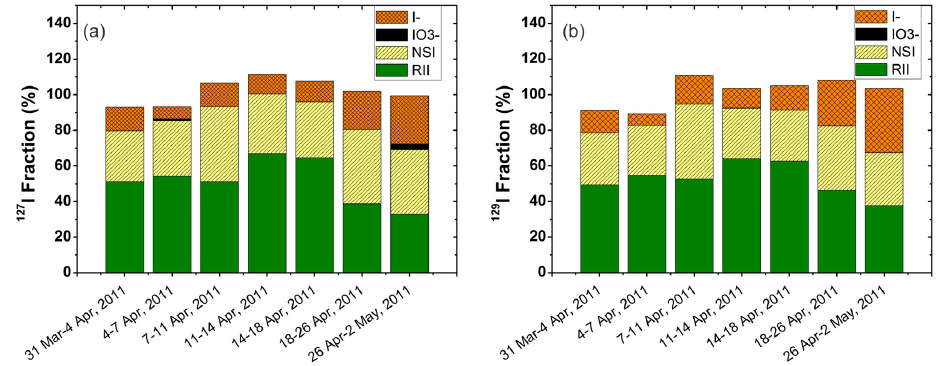
Figure 5. Distribution of iodine species in the aerosol samples for 127 I (a) and 129 I (b) , compared with the measured concentrations of total 127 I and 129 I in bulk